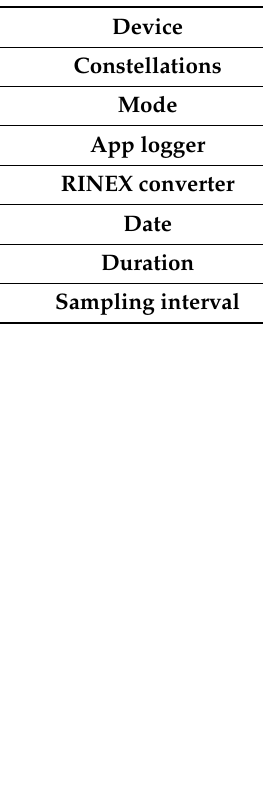
Table 3. GNSS data